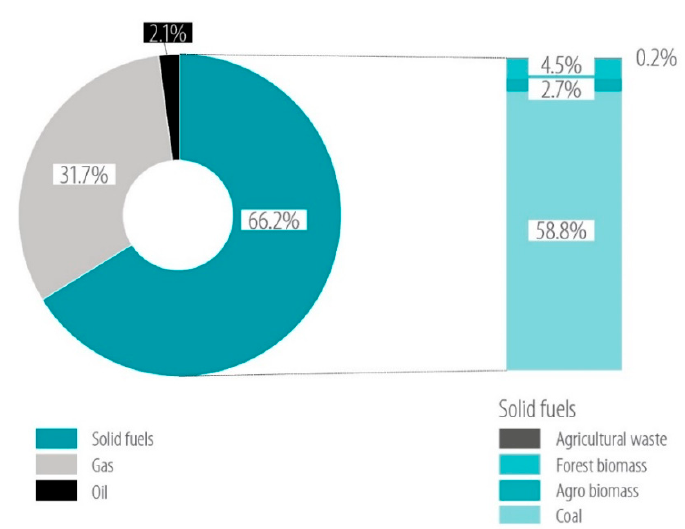
Figure 6. Types of fuels used to generate heat for heating purposes in 2017 (based on Reference [25]).